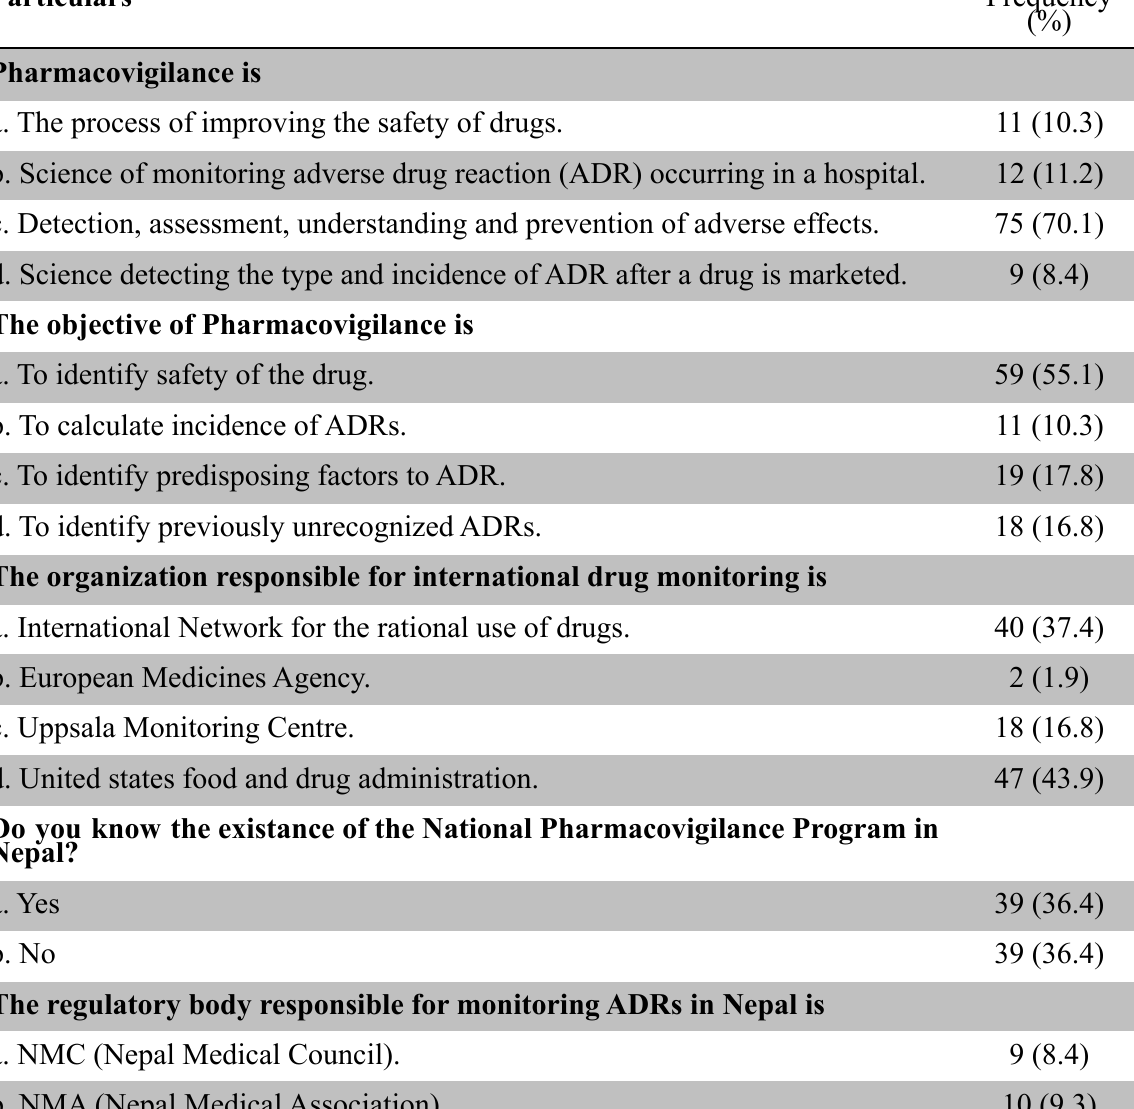
Table 1: Knowledge regarding pharmacovigilance (N=107)